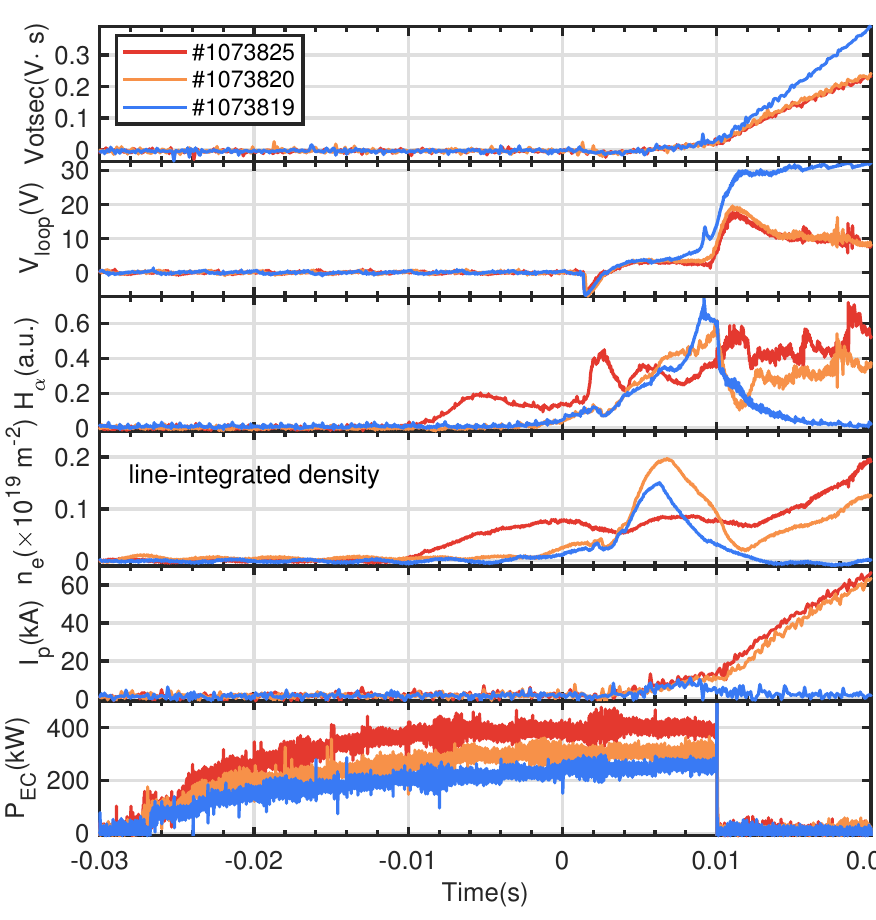
Figure 5. Evolution of key signals with di ff erent ECH power for assisted